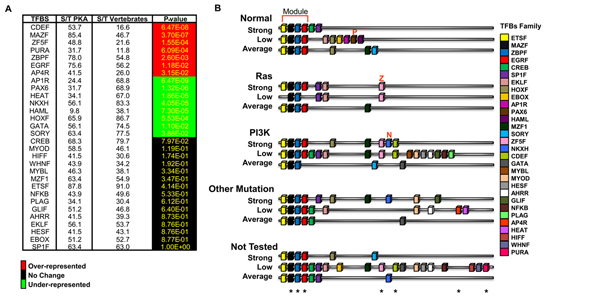
TFBS identification by using the enrichment as parameter. (A) The panel shows for each TFBS, recognized as relevant (present in ≥ 70% of the promoters of 41 PKA pathway-encoding genes) the percentage of promoters in our collection that contain the motif as compared to Matrix Family Library on vertebrates. This percentage has been calculated by dividing the total number of promoters containing the motif (S) by the total number of promoters (T). Color-coding scheme on the right of the panel. (B) Schematic representation of the TFBSs (color-coded as shown on the right of the panel) identified in the promoters of the 15 subgroups described in the text and in Figure 3. Each cartoon represents the promoter structure resulting from the average of the TFBS identified in ≥ 70% of the gene promoters for each subgroup. The asterisks on the bottom of the cartoon indicate the over-represented TFBS, as scored in panel A, for all the 41 PKA pathway-encoding genes.